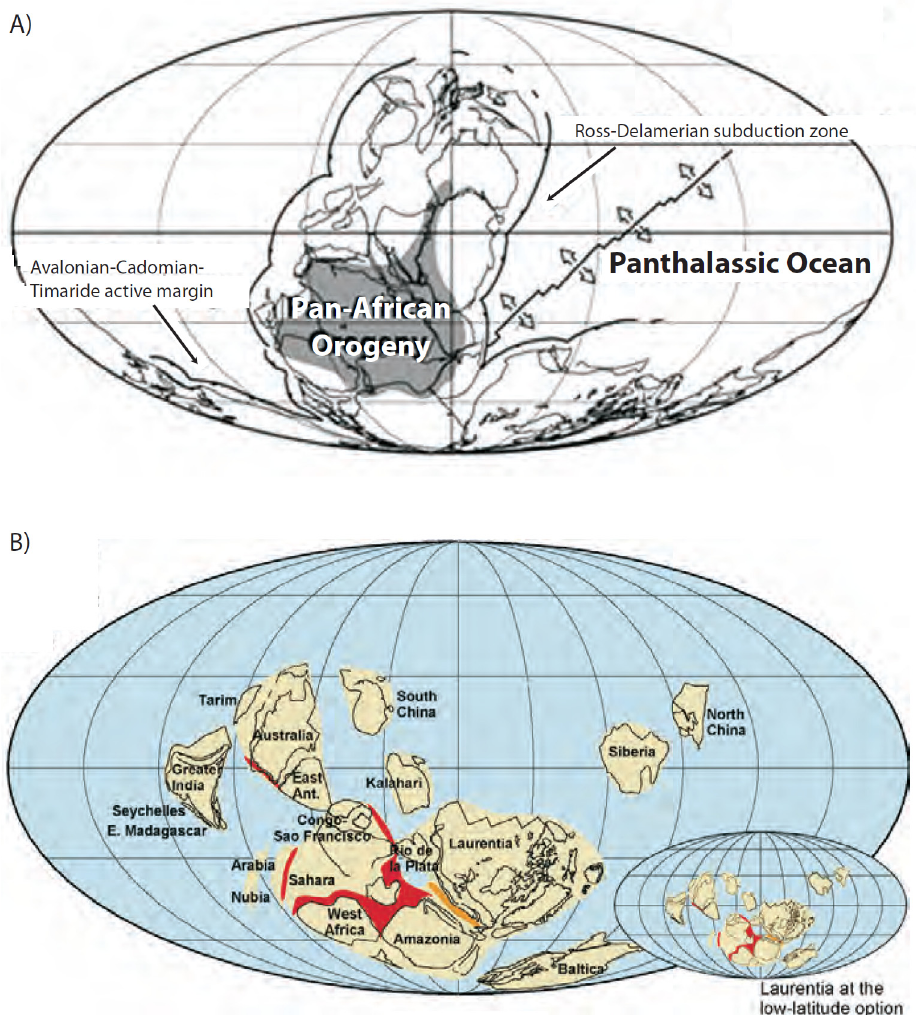
Figure 3. Two contrasting paleogeographic visions for a common interval at 600 Ma